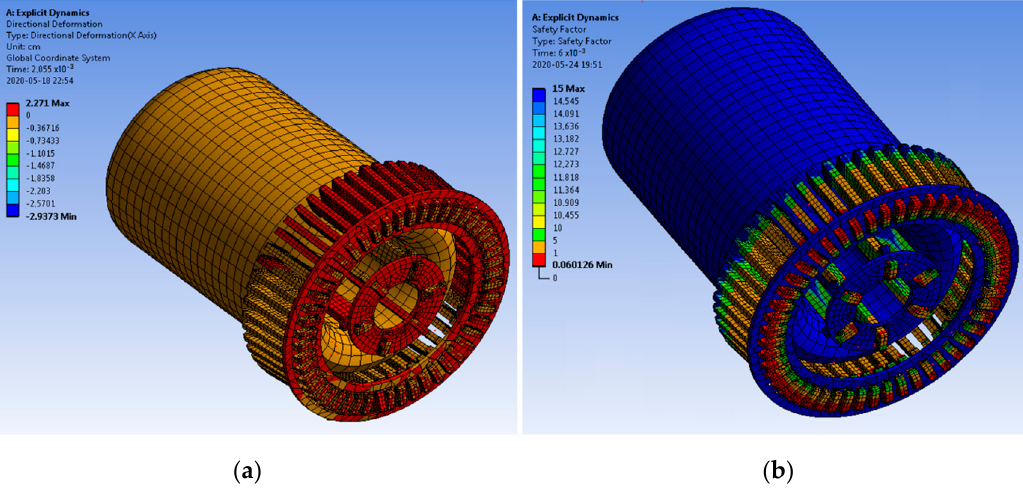
Figure 9. View of the tulip contact analyzed in ANSYS: ( a ) View of the direct values of contact deformation and ( b ) the safety factor.